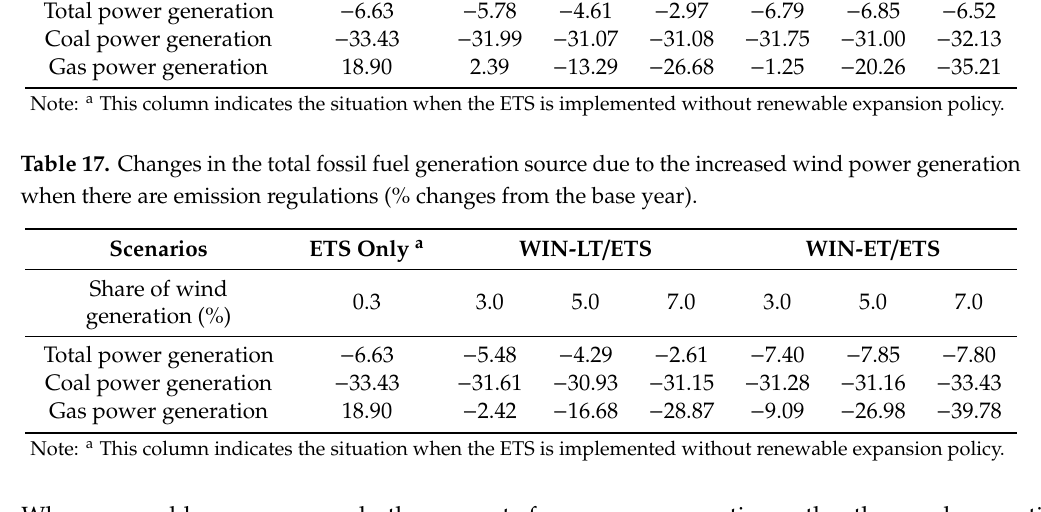
Table 16. Changes in the total fossil fuel generation source due to the increased solar PV power generation when there are emission regulations (% changes from the base year). Scenarios ETS Only a SOL-LT / ETS SOL-ET / ETS Share of solar PV 1.0 generation (%)